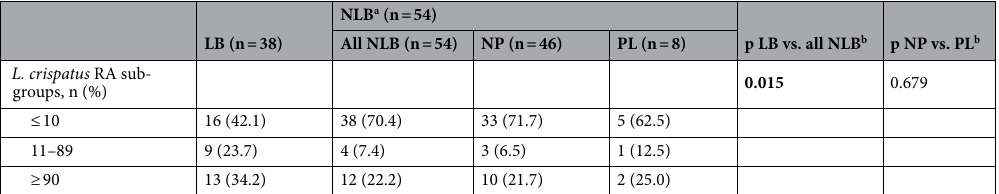
Table 3. Endometrial microbiota characteristics by birth outcome. Significant values are in [bold]. BV bacterial vaginosis, CI confidence interval, IQR interquartile range, LB live birth, mo months, NLB no live birth, NP no pregnancy, NS not significant, PL pregnancy loss, RA relative abundance, SD standard deviation. Only samples with ≥ 100 16S rRNA sequencing reads (V1–V2 region) were included. a The NLB participants included participants with a pregnancy loss (PL) as well as participants who did not get pregnant at all (NP). b ANCOM-BC analyses were corrected for multiple testing and were used to identify individual taxa with significantly different RAs in comparison groups in an untargeted manner. In the targeted analyses (using prespecified bacterial groups and subgroups), we assumed that the data were not normally distributed. All p-values were calculated by Wilcoxon rank sum tests only, but we are showing both median and mean RAs for illustrative purposes. c Relative abundances are presented as percentages of the number of reads of the taxon out of the total number of bacterial reads. d The group of “other bacteria” contains skin bacteria, unresolved bacteria and minority taxa that could not be assigned to any of the other